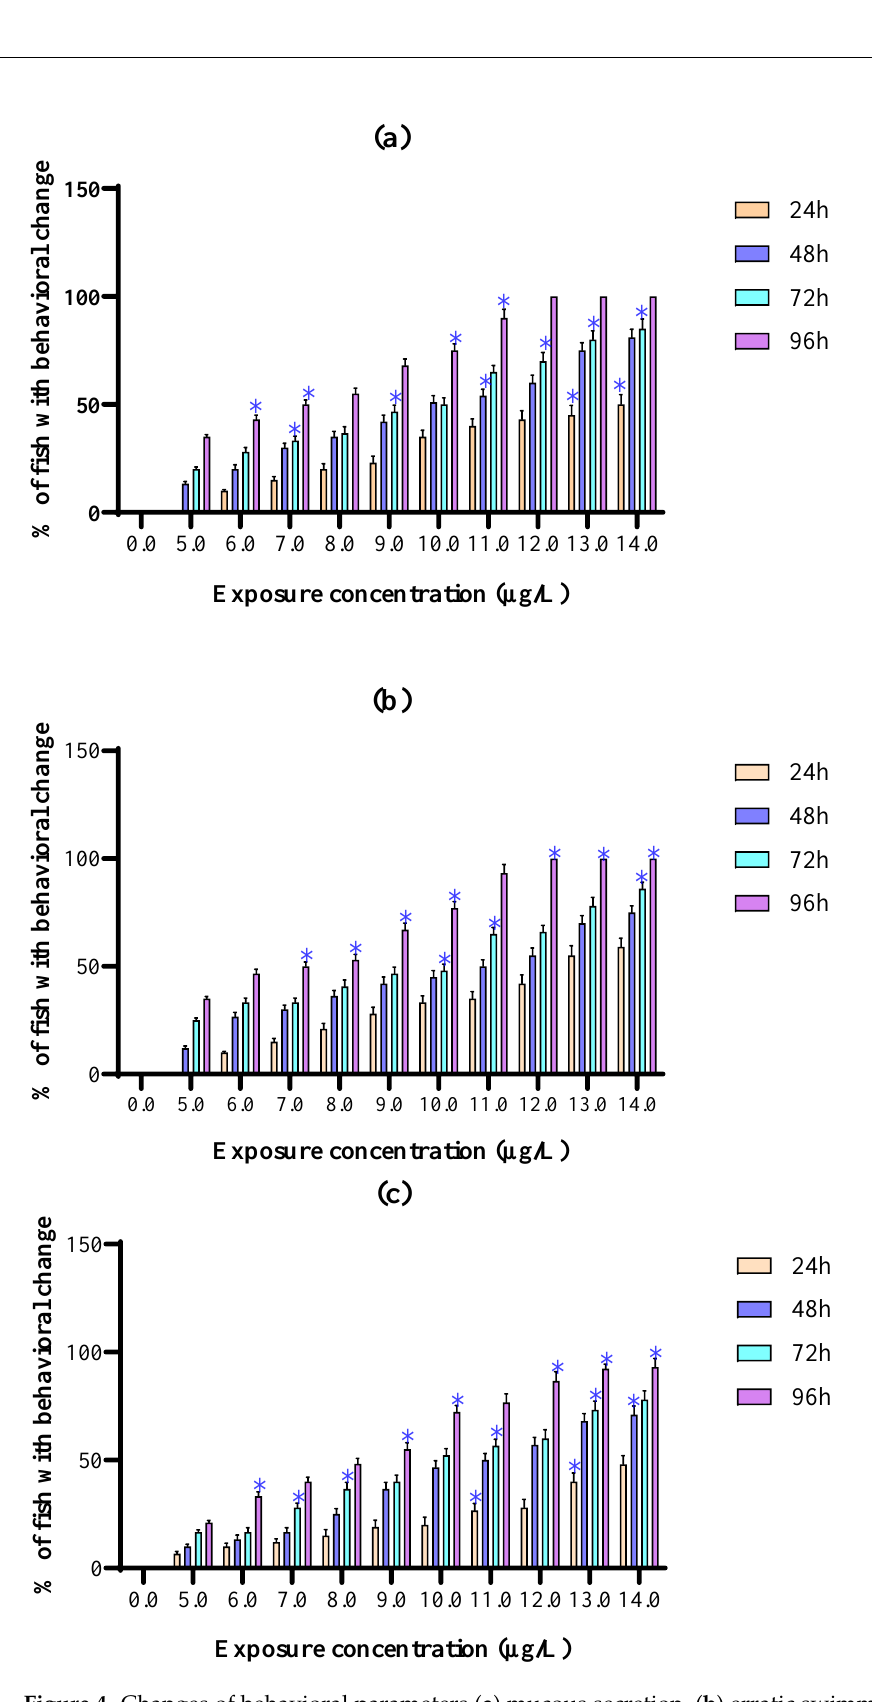
Figure 4. Changes of behavioral parameters ( a ) mucous secretion, ( b ) erratic swimming behavior, and ( c ) loss of balance behavior in O. mossambicus exposed to different concentrations of deltamethrin. Asterix indicates significant differences in mean parameters ( p < 0.05) across exposure intervals for each concentration.